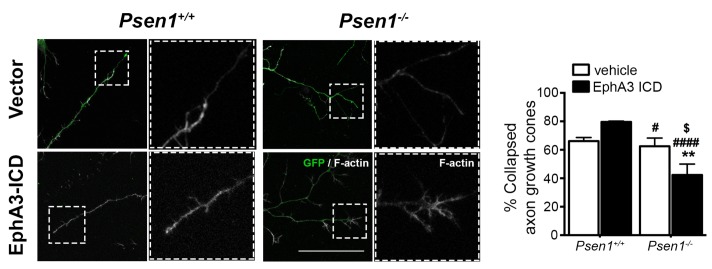
Effect of EphA3 ICD on axon growth cone collapse.EphA3 ICD regulates growth cone collapse in hippocampal neurons. Hippocampal Psen1+/+ and Psen1-/- neurons were transfected with vector (pWPI-GFP) or EphA3 ICD (green) at 2 DIV and fixed and stained with F-actin (white) at 4 DIV. The percentage of collapsed growth cones is significantly different between genotypes (****p<0.0001), whereas EphA3 ICD induces a decrease in the percentage of collapsed growth cones in PS1-/- neurons. N = 26–33 neurons/group. Statistics was tested by two-way ANOVA followed by Bonferroni post hoc test. **p<0.01 compared with controls, ####p<0.0001 compared with Psen1+/+ neurons transduced with EphA3 ICD; $p<0.05, compared with vector Psen1-/-. Scale bar, 50 μm.